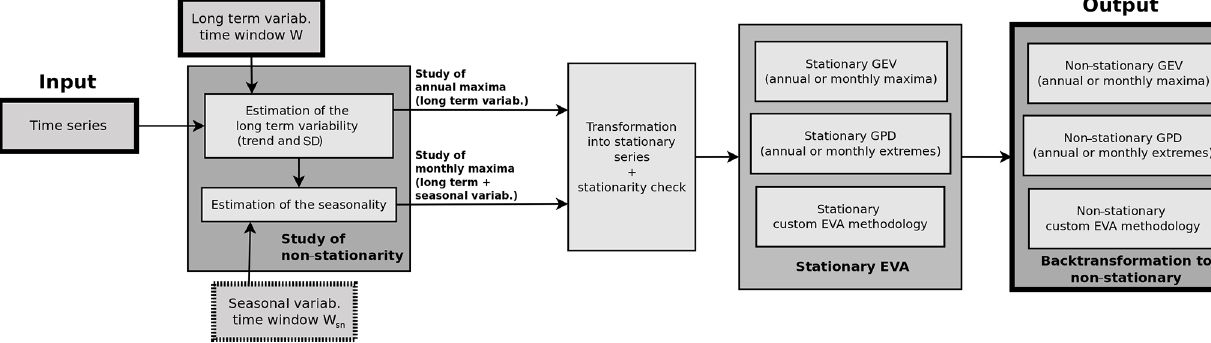
Figure 1. TS methodology: block